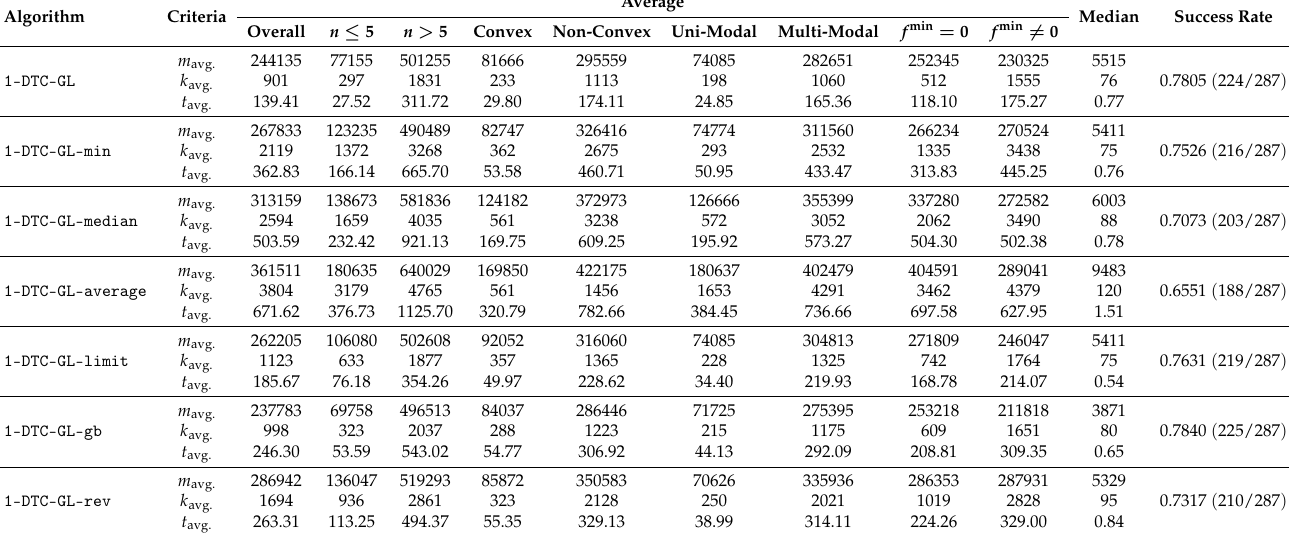
Table 2. The average number of function evaluations ( m avg. ), iterations ( k avg. ) and execution time ( t avg. ) using 1-DTC-GL and six newly introduced variations, on the DIRECTGOLib v1.2 test problems